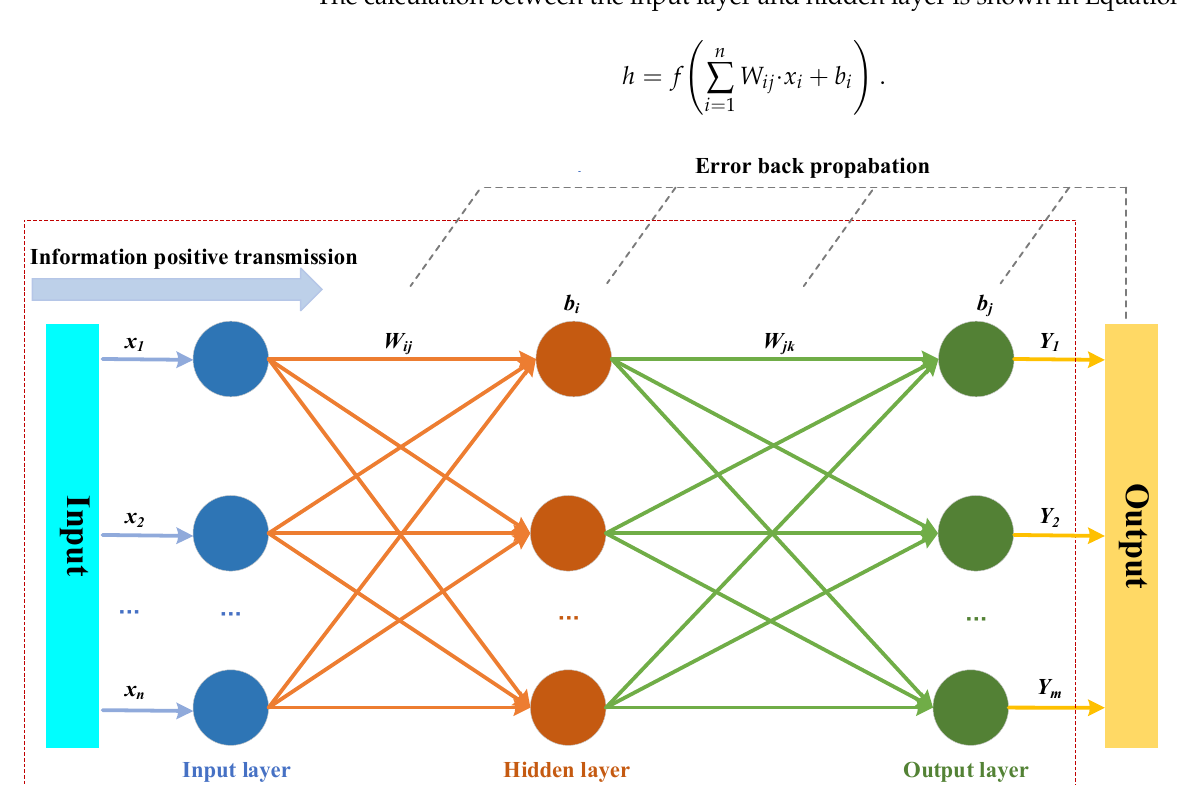
Figure 1. Structure of typical backpropagation (BP) neural network.